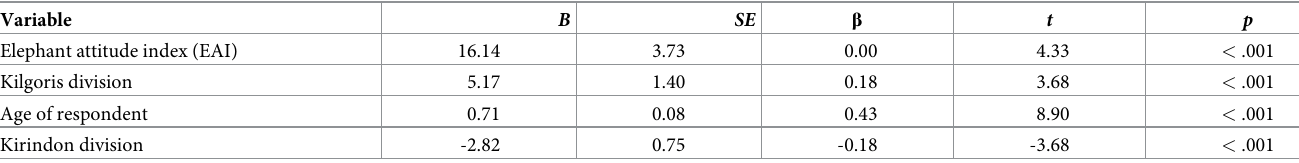
Table 5. Regression results for elephant attitude index (EAI).